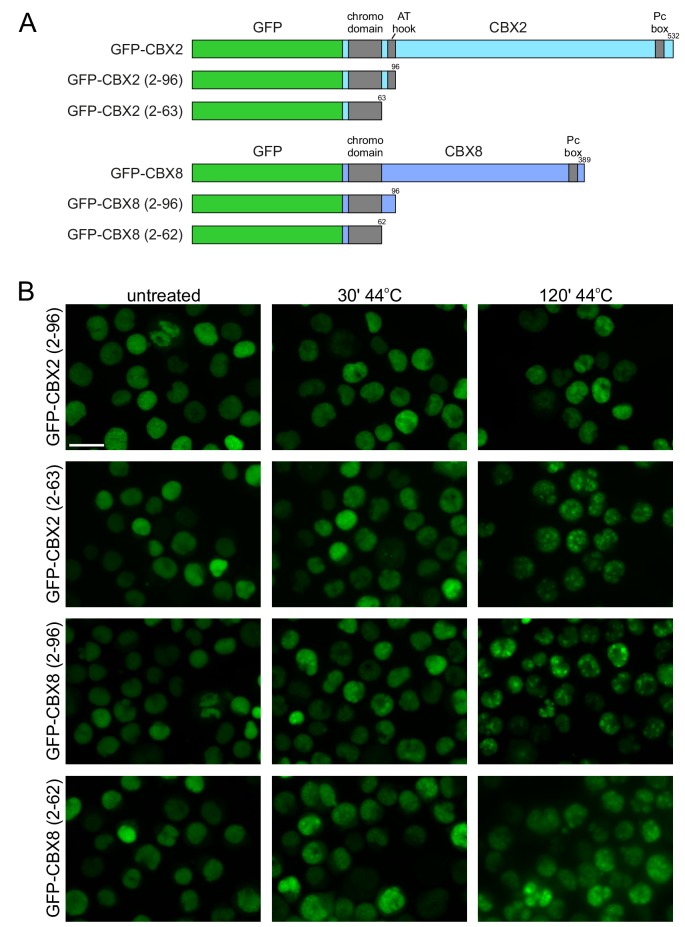
The N-terminus of CBX2 and CBX8 including the chomo domain is sufficient for HS-induced nucleolar localization.(A) Schematic representation of full length GFP-CBX2 and GFP-CBX8 and generated truncated GFP-fusion constructs. (B) Representative images of K562 cells stably expressing GFP-CBX2 (2–96), GFP-CBX2 (2–63), GFP-CBX8 (2–96), or GFP-CBX8 (2–62) that are either untreated or exposed to a 30 min or 2 hr HS at 44°C.